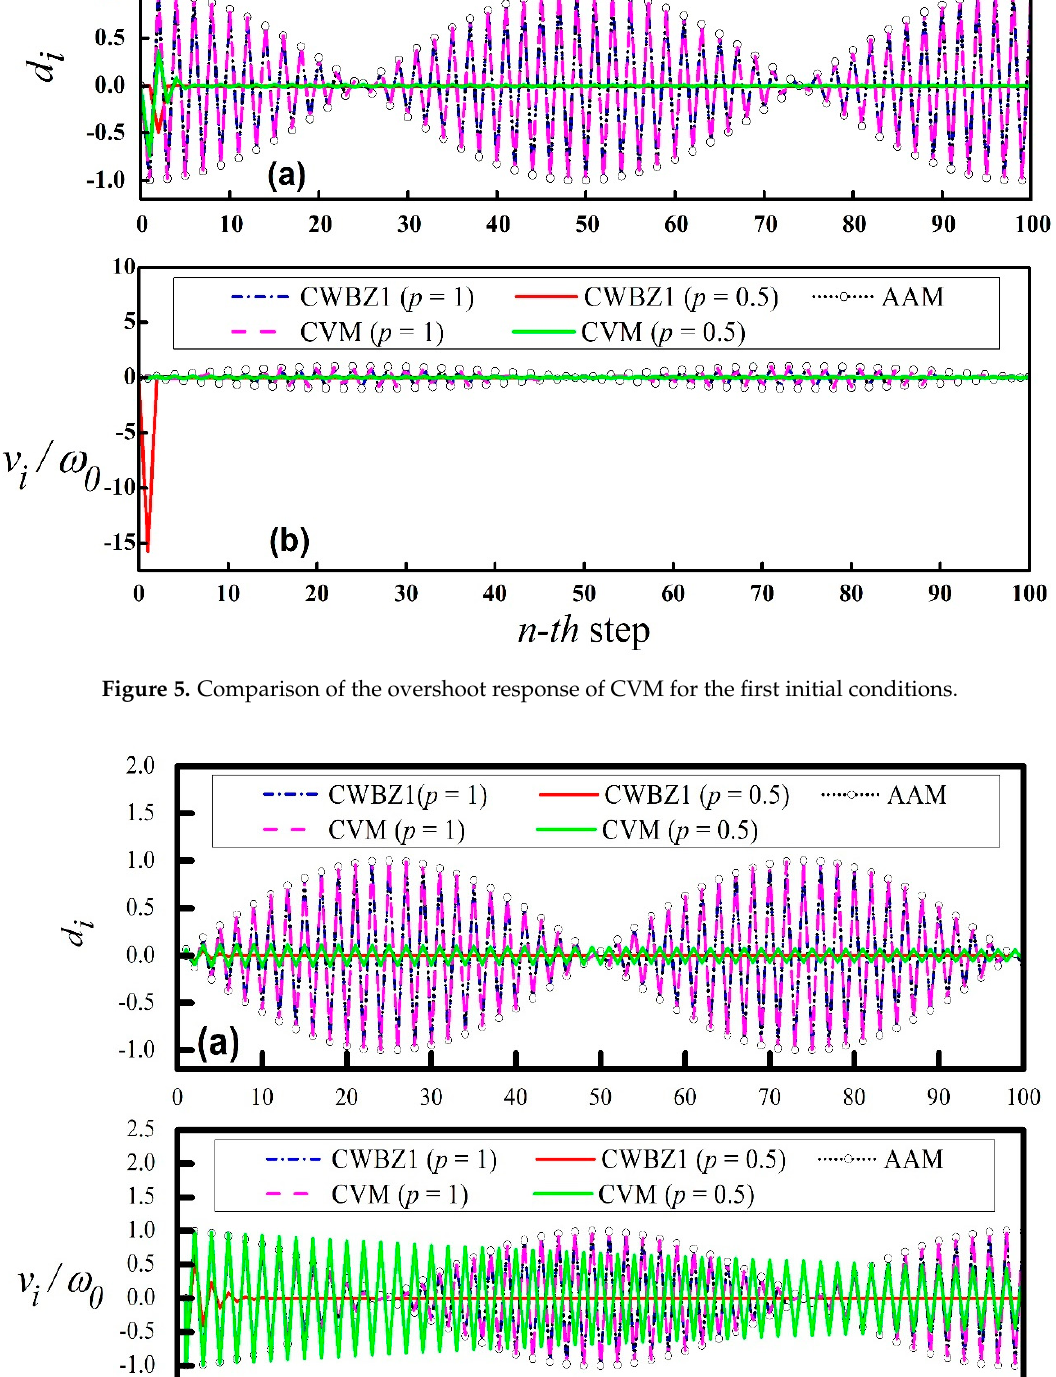
Figure 7. Comparison of the overshoot response of CVM for the third initial conditions.